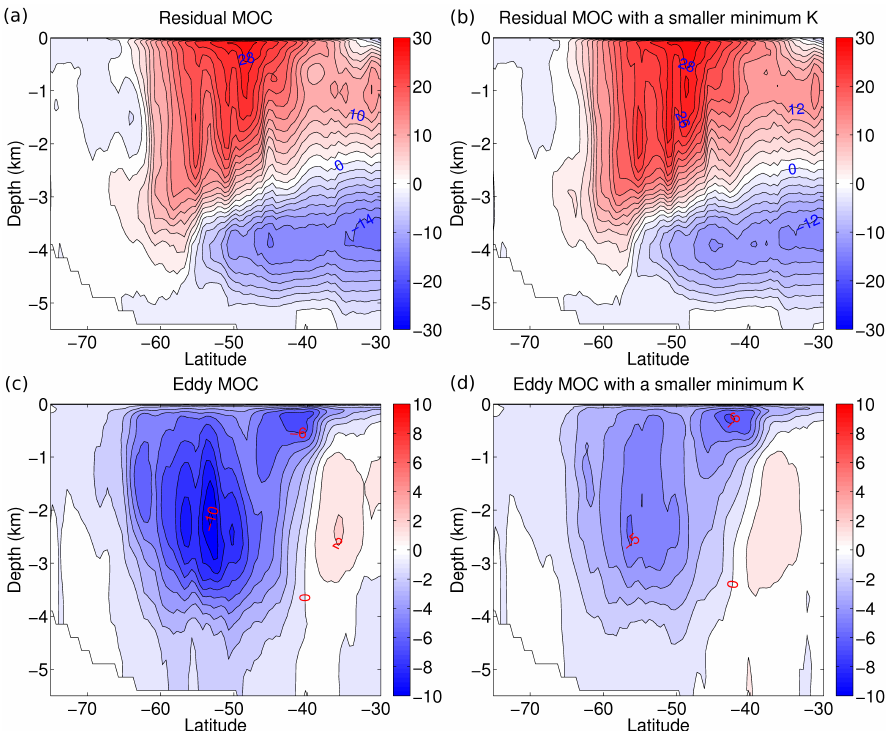
Fig. 117. Residual MOC [Sv] for (a) a reference run and (b) a run Fig. 17. Residual MOC (Sv) for (a) a reference run and (b) a run with a smaller N min (0.1). (c) , (d) are the same as (a) , (b) , respectively, but for the eddy with a smaller N min (0.1). (c) , (d) are the same as (a) , (b) , respec- tively, but for the eddy MOC.